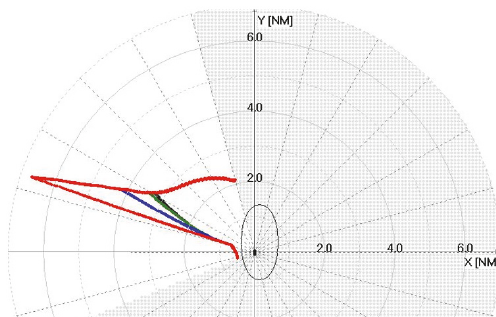
Figure 18: Action lines for stand-on crossing encounter with a target, whose true speed is 18 knots. Assumed are turns of 40 ∘ to starboard without speed reduction (red) or with speed reduced by 3 knots (blue), 6 knots (green), and 9 knots (black).